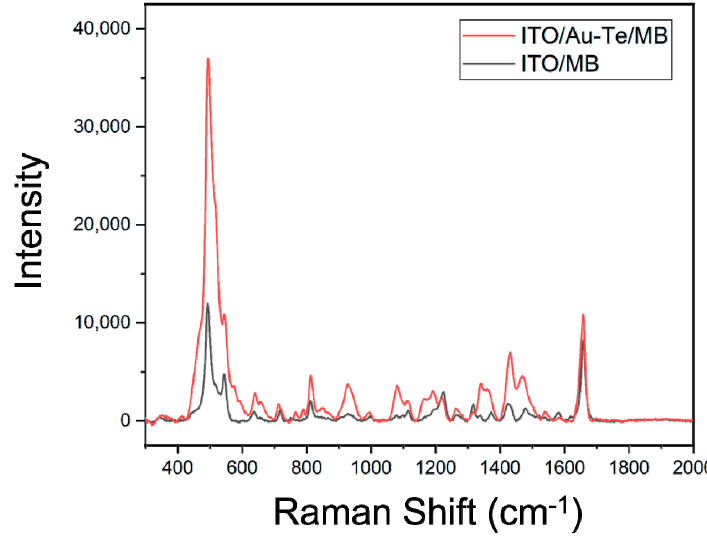
Figure 3. Raman spectrum of methylene blue on ITO, ITO/Au–Te.